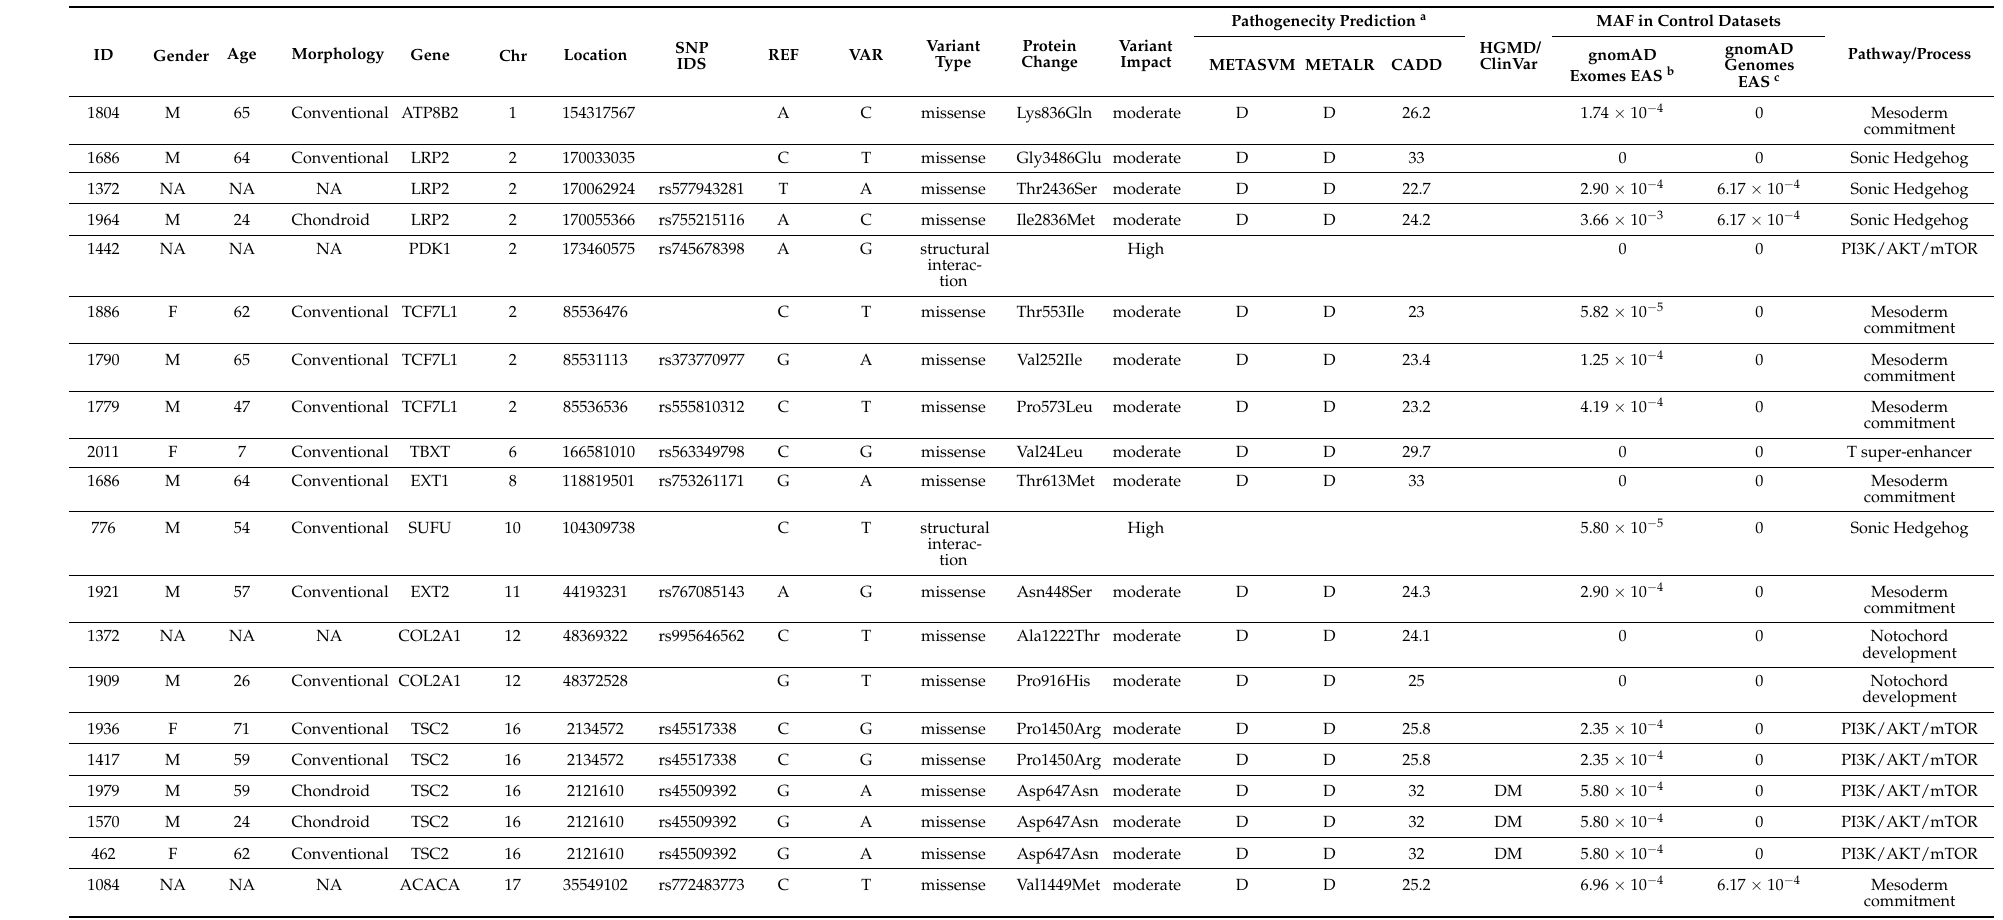
Table 2. Potentially pathogenic variants in the Chinese